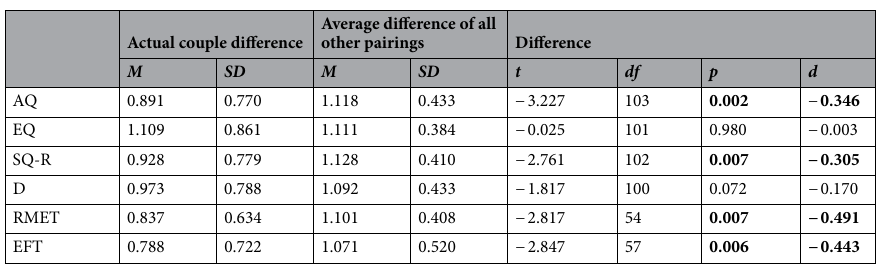
Table 3. Comparison of actual couple similarity for autism-related variables with the average difference scores calculated by pairing each participant with all other potential other-sex partners in the dataset. AQ, Autism Spectrum Quotient; EQ, Empathy Quotient; SQ-R, Systemizing Quotient-Revised; D, difference in standardized EQ (E) and SQ-R (S) scores; RMET, Reading the Mind in the Eyes Test; EFT, Embedded Figures Task. Effects in bold are statistically significant ( p < 0.05, two-tailed) and remained so after Bonferroni correction (required α level: p < 0.008).